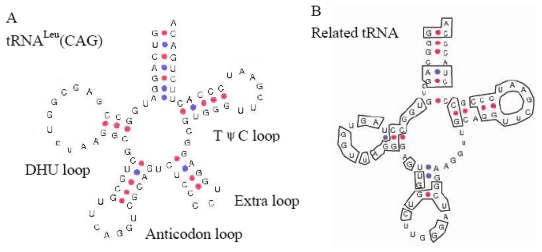
The secondary structure of tRNALeu(CAG) in Xenopus laevis taken from [20] (A) and the tRNALeu-related Cn-SINE family (B). The sequences identical to tRNALeu(CAG) in Cn-SINE are boxed.